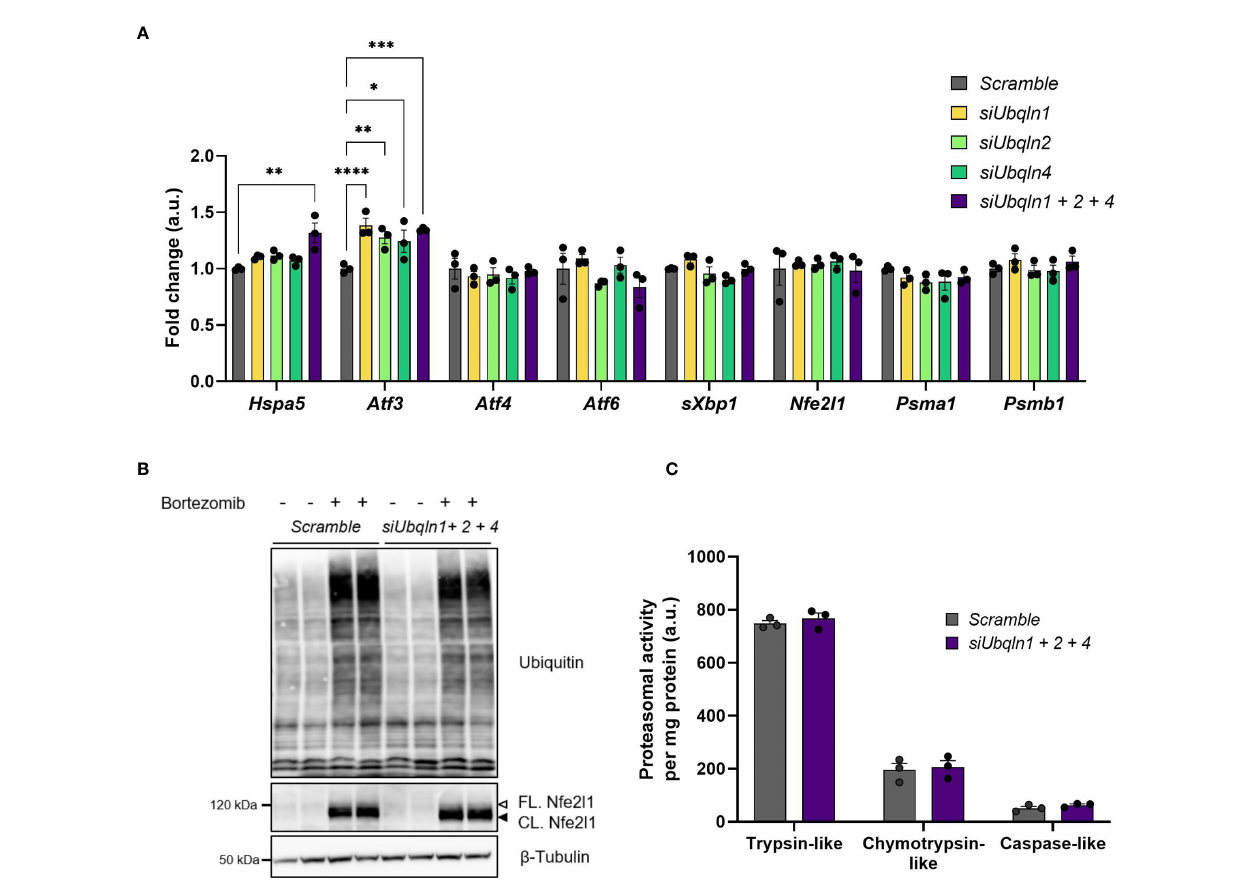
FIGURE 4 | Ubqln1, 2 and 4 are not required for maintaining proteostasis in brown adipocytes. Ubiquilins were silenced by siRNA-mediated knockdown in imBAT. (A) , Relative gene expression measured by qPCR ( n = 3 technical replicates mean ± SEM). *P adj < 0.05, **P adj < 0.01 and ***P adj < 0.001 by one-way ANOVA with Bonferroni post-hoc test. (B), Representative ubiquitin immunoblot, imBAT treated with DMSO (control) or 100 nM bortezomib for 6 h ( n = 2 technical replicates, representative blot of 2 independent experiments). (C) , Proteasomal activity ( n = 3 technical replicates, mean ± SEM). *P adj < 0.05, ***P adj < 0.001 by one-way (A) or two-way (D) ANOVA versus Scramble with Bonferroni post-hoc test (A, C)